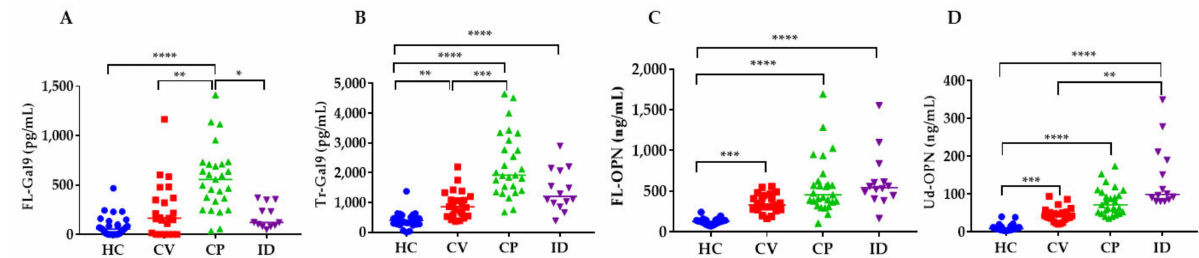
Figure 2. Levels of FL-Gal9 ( A ), Tr-Gal9 ( B ), FL-OPN ( C ), and Ud-OPN ( D ) in CV, CP, ID, and HC. HC: healthy control; CV: COVID-19 infection with mild clinical symptoms; CP: COVID-19 associated with pneumonia; ID: infectious diseases FL-Gal9; Full-length Gal-9, Tr-Gal9; truncated Gal-9, FL-OPN; full-length OPN, Ud-OPN; undefined OPN, **** p < 0.0001,